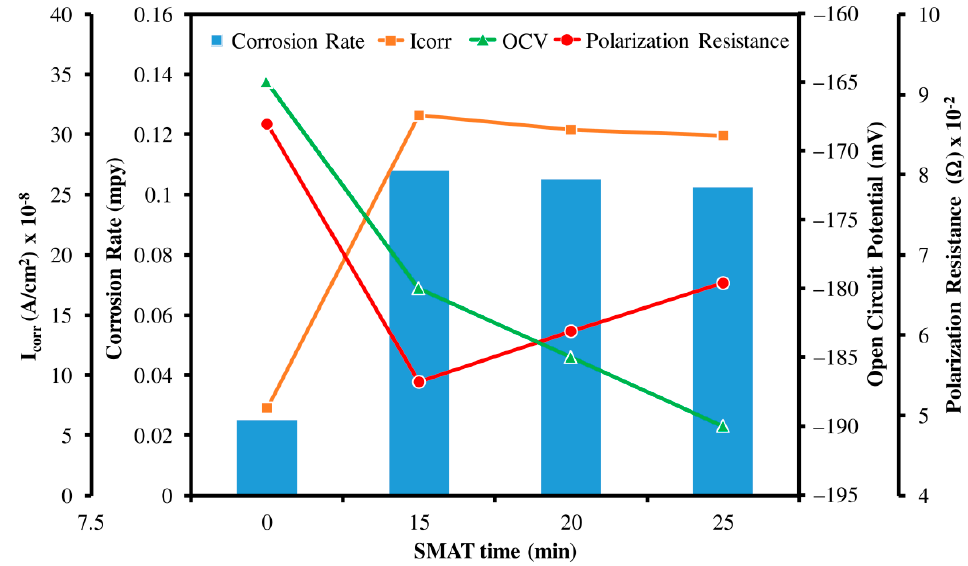
Figure 9. Corrosion rate, Icorr, polarization resistance and open circuit potential as a function of SMAT time.